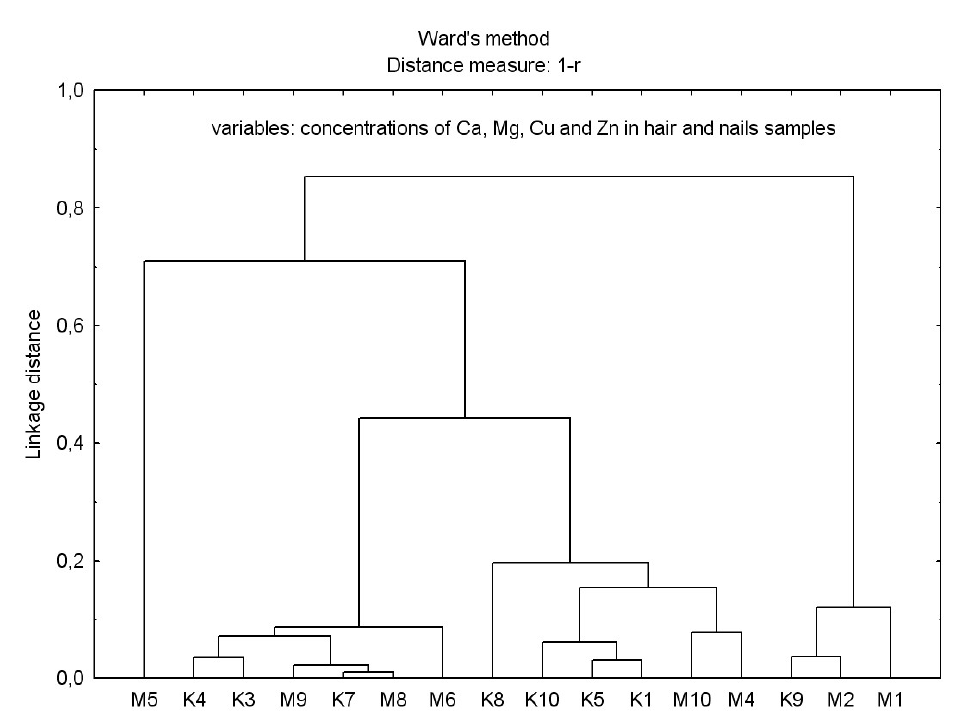
Figure 4. Dendrogram of cluster analysis made on the basis of Ward’s method and 1-r distance for the essential elements.